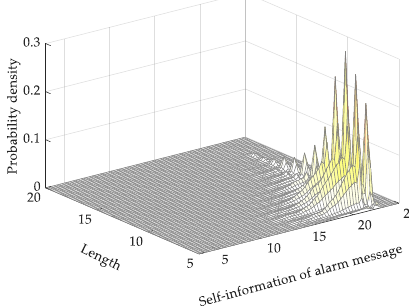
Figure 10. Probability density map of self-information of alarm messages.